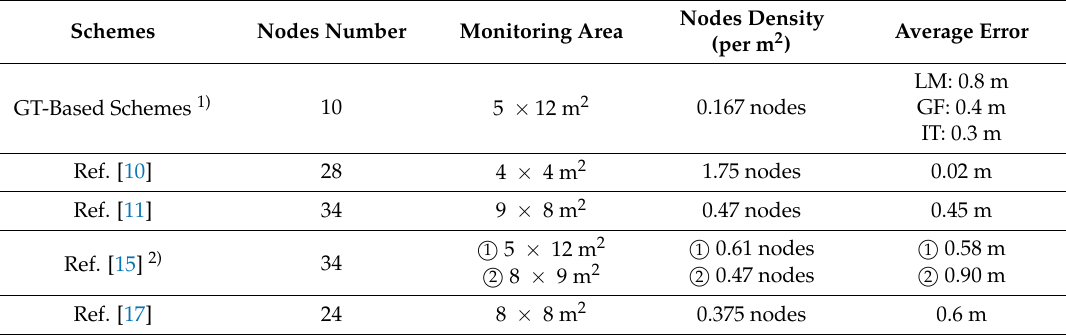
Table 1. Comparison of wireless node density and positioning accuracy of various passive tracking schemes.